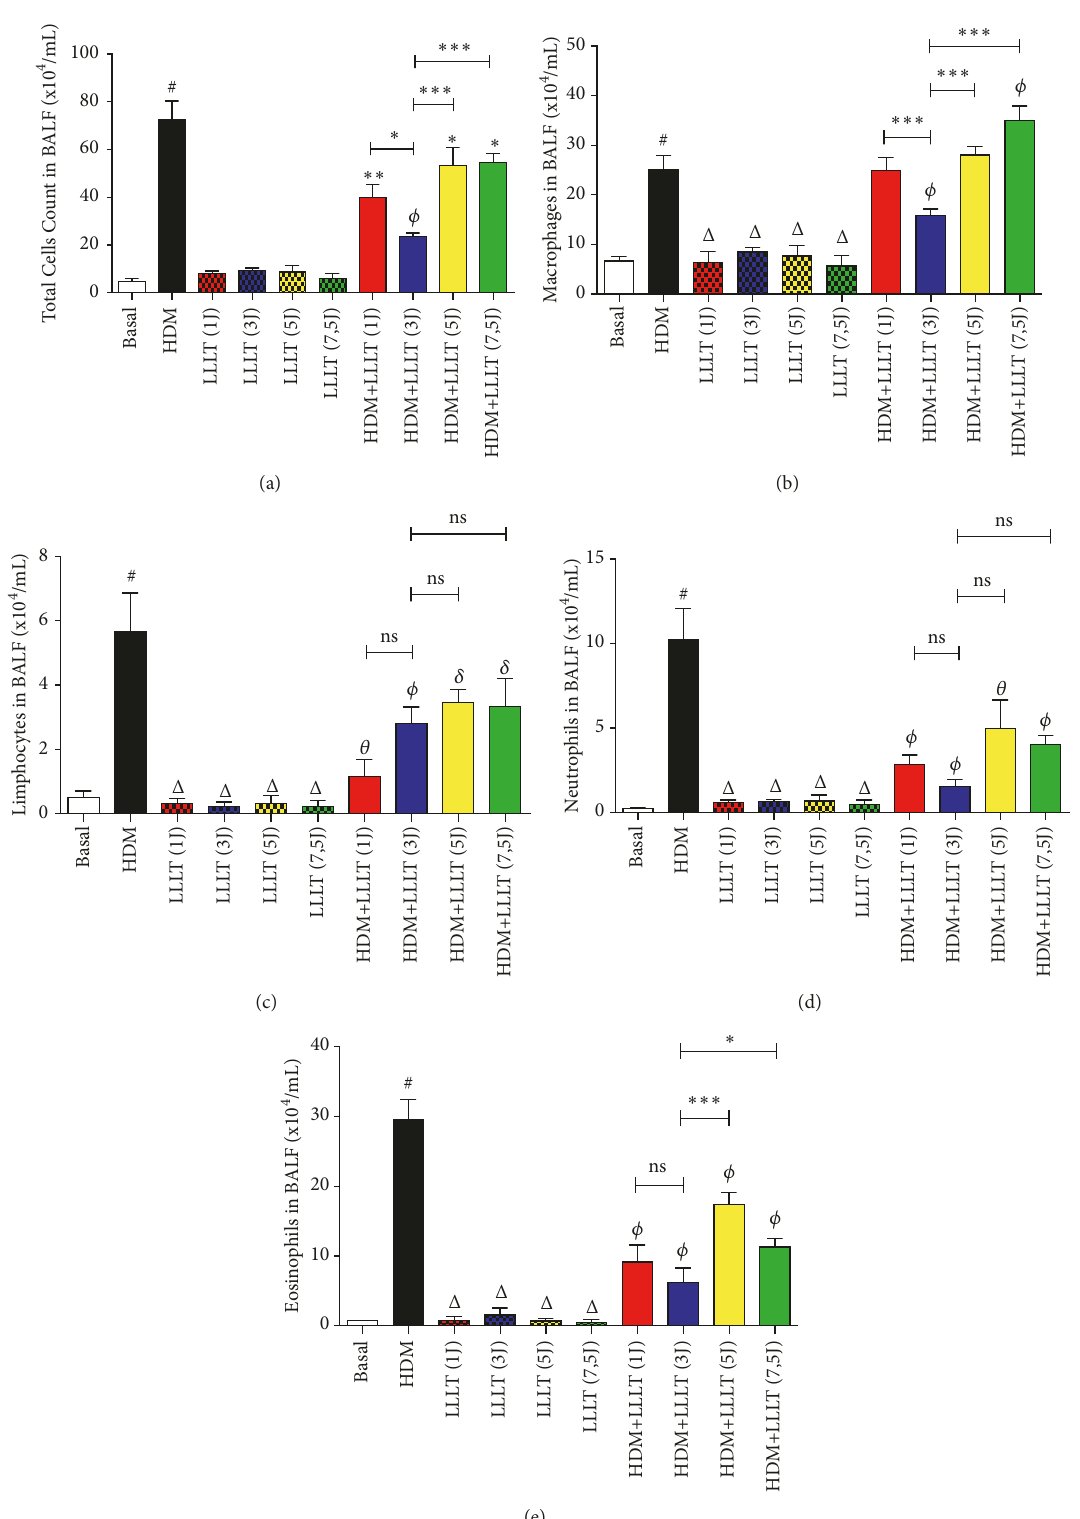
Figure 1: Effect ofLLLT on thetotalnumberof cells(a)and thenumberof macrophages(b), lymphocytes (c),neutrophils(d), and eosinophils (e) recovered from the BALF. The groups used in the experiment were Basal (unmanaged animals), asthmatics (HDM) (animals immunized and challenged with HDM), LLLT (animals only treated with LLLT), and HDM+LLLT (animals sensitized and challenged with HDM and subsequently treated with LLLT). The results refer to the use of 10 mice in each experimental group. Values expressed as mean and standard deviation. # p < 0.001 when compared to Basal group; 𝜃 p < 0.001, 𝜙 p < 0.01, and 𝛿 p < 0.05 when compared to the asthmatic group (HDM) and ns (not significant); ∗ p < 0,05 and ∗ ∗∗ p < 0,001 when compared HDM+LLLT (3J) group with the other groups treated with other